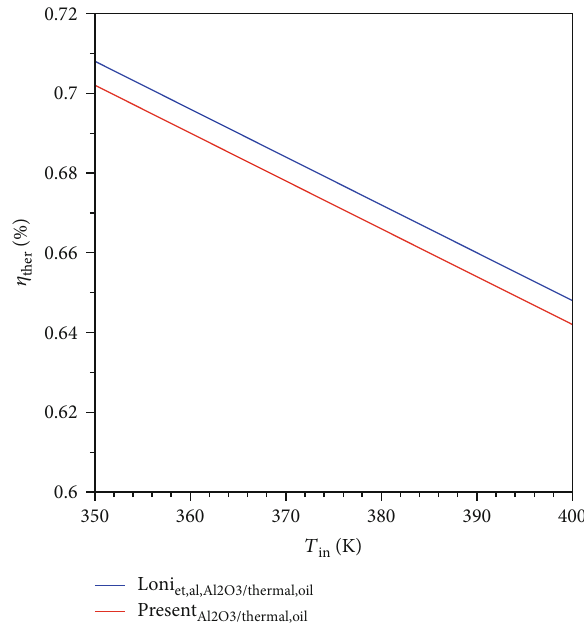
Figure 8: Validation of solar dish collector model with Loni et al.